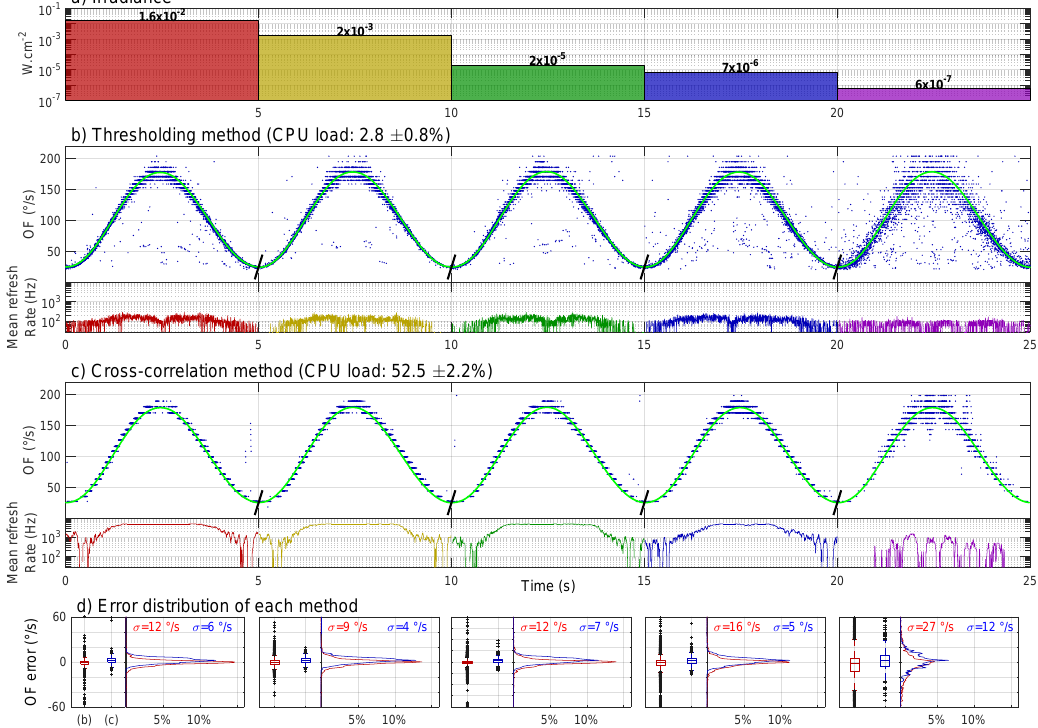
Figure 5. ( a ) The five levels of irradiance from 6 × 10 − 7 W · cm − 2 to 1.6 × 10 − 2 W · cm − 2 (i.e., from 0.2 lux to 12,000 lux for human vision) used during the first part of the experiments (see the experimental setup shown in Figure 4). ( b , c ) OF measurements obtained with the M 2 APix sensor using (b) the thresholding method ( F e = 1 kHz) and (c) the cross-correlation method ( F e = 500 Hz) for the 10 LMSs during 10 laps of the moving pattern. Tests were run separately for each of the five lighting conditions. Each blue dot represents one OF measurement of one LMS; however, the mean output refresh rate is the average of the number of OF measurement from the 10 LMSs in 1s. The green line represents the OF ground-truth computed using Equation (2). ( d ) Error distribution of each time-of-travel method: the thresholding method is in red and the cross-correlation method in